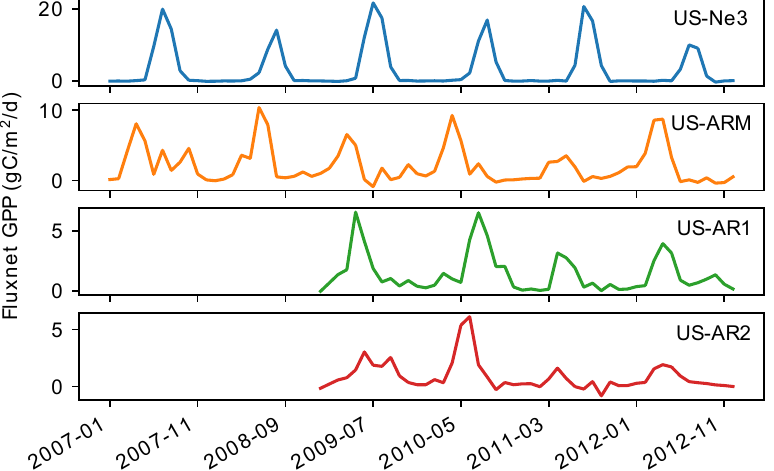
Figure 15. Gross primary production (gC/m 2 /day) over select FLUXNET stations in 2007–2012. More detailed information about the stations can be found in Table